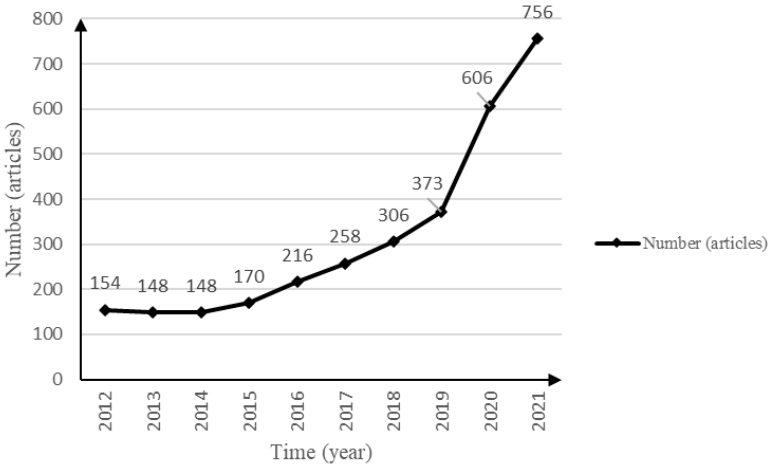
Figure 3. Number of publications in the literature on concrete compressive strength prediction 2012 –